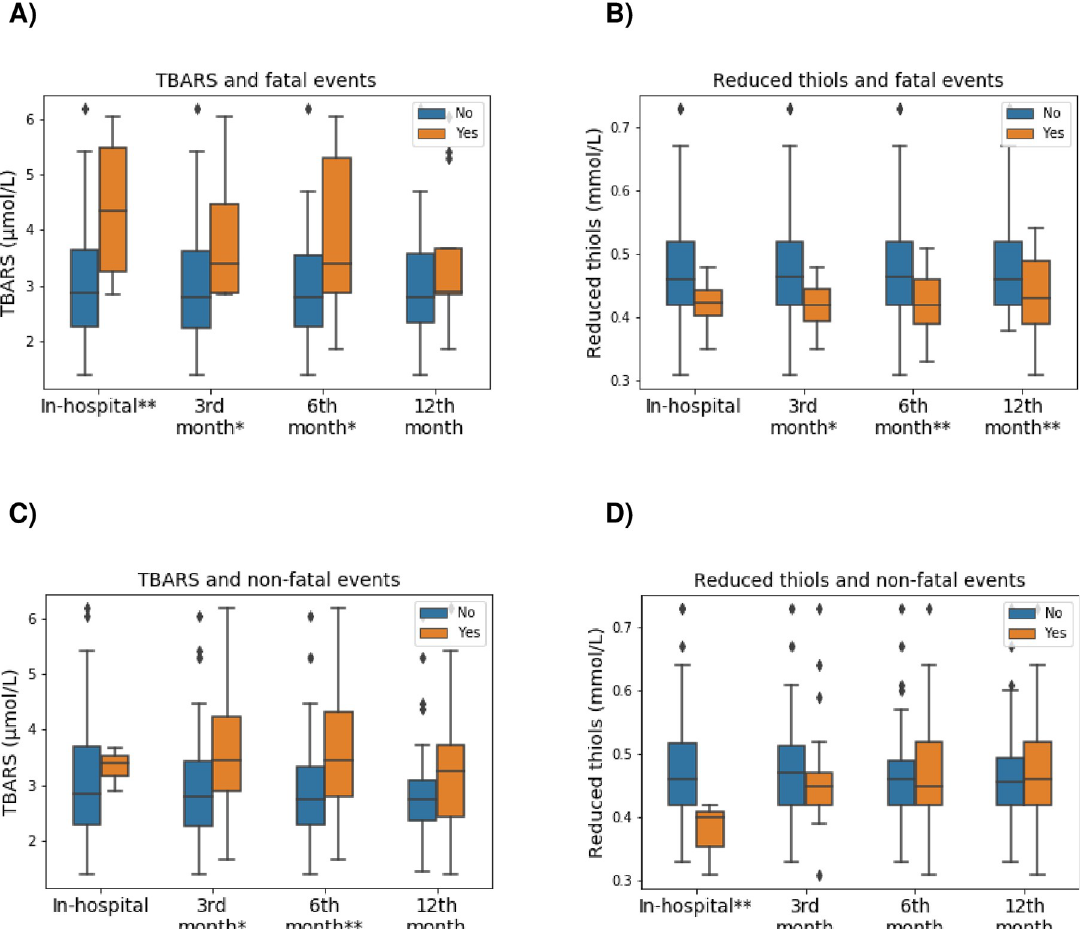
Fig 1. Differences between plasma levels of TBARS and reduced thiols in the groups of interest. (A) TBARS and fatal events.(B) Reduced thiols and fatal events. (C) TBARS and non-fatal events. (D) Reduced thiols and non-fatal events. The results are shown as mean ± standard deviation. TBARS–Tiobarbituric acid reactive substances. � Refers to P -value < 0.10. �� Refers to P -value <